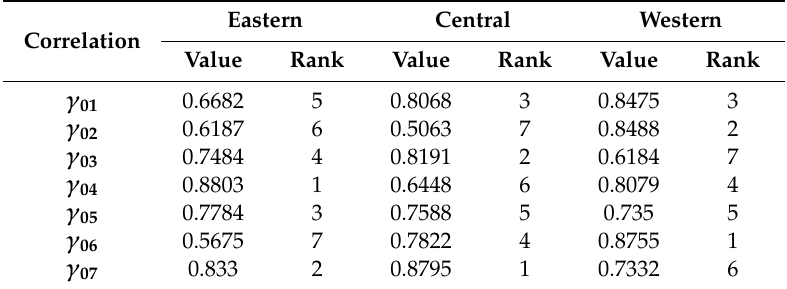
Table 9. Grey correlations and ranks between intra-regional di ff erence of provincial e ffi ciency di ff erence of Chinese township hospitals and the determinants in each